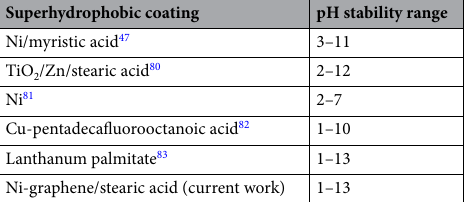
Superhydrophobic coating pH stability